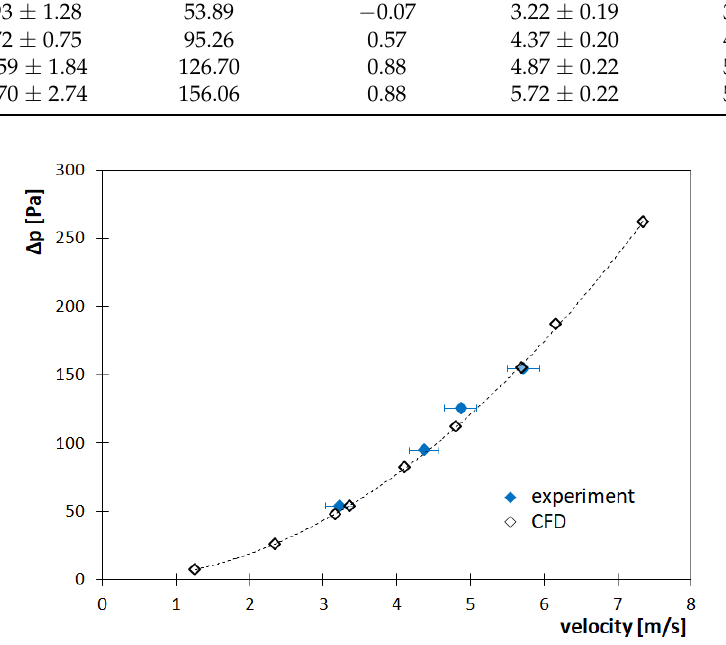
Figure 5. Comparison of numerical and experimental results.